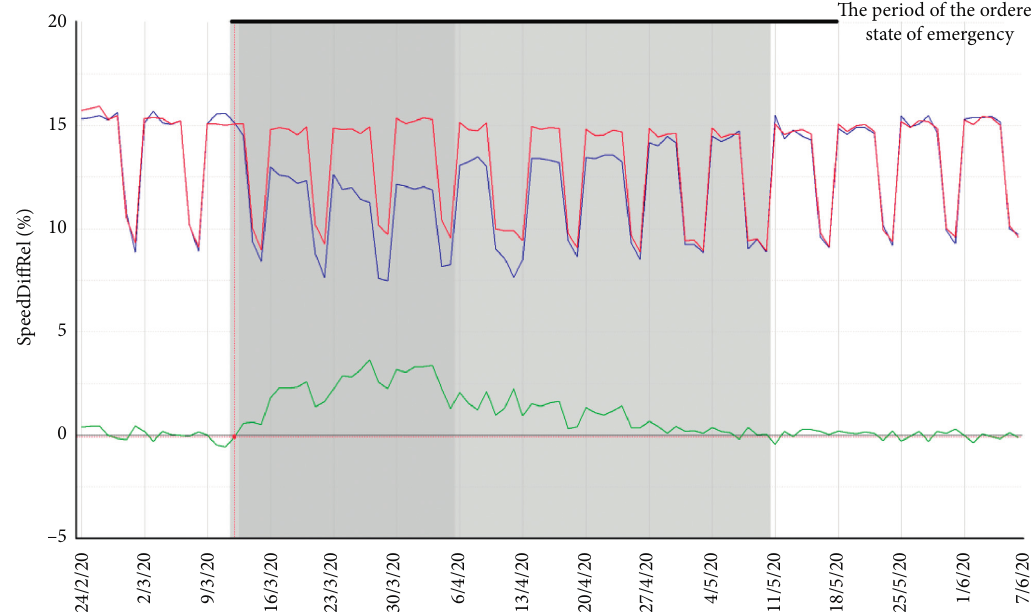
Figure 5: Deviation of the measured (blue) and predicted (red) speed values from FreeFlowSpeed, for all roads in the period from 24 February to 7 June 2020. Green curve indicates the difference in the real and expected values of SpeedDiffRel in percentage points. These are the daily average